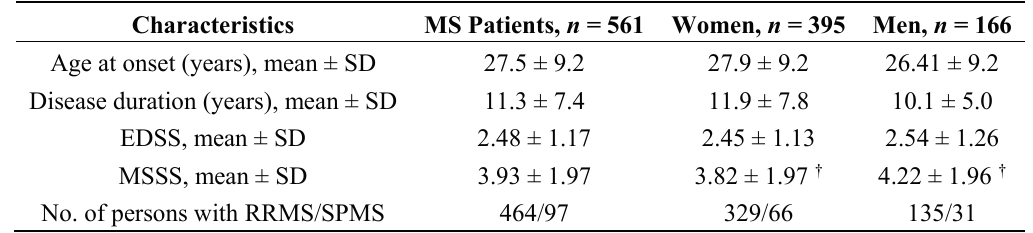
Table 2. Clinical characteristics of bout-onset MS